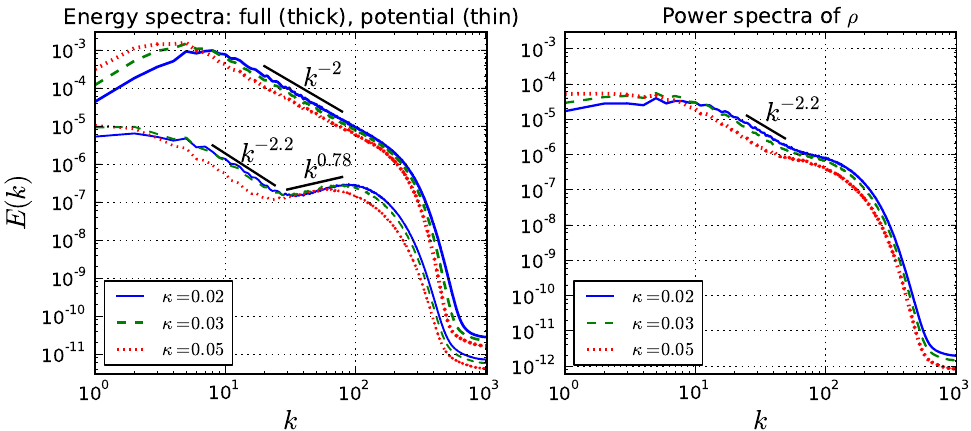
Figure 2 . (Left): Newtonian energy spectra of the inverse-cascade simulations plotted on a log-log scale. The spectra corresponding to the full velocity (cid:12)eld (thicker lines) and the curl-free potential part (thinner lines) are displayed. All energy growth rate cases are displayed, with the same colour coding and line styles as in (cid:12)gure 1. The best-(cid:12)t power laws for the full spectra over the range k = 20 (cid:0) 80 in order of decreasing dissipation strength are ( (cid:0) 1 : 80 ; (cid:0) 1 : 89 ; (cid:0) 1 : 96). (Right): power spectra of the energy density (cid:26) for all energy growth rates, plotted on a log-log scale.